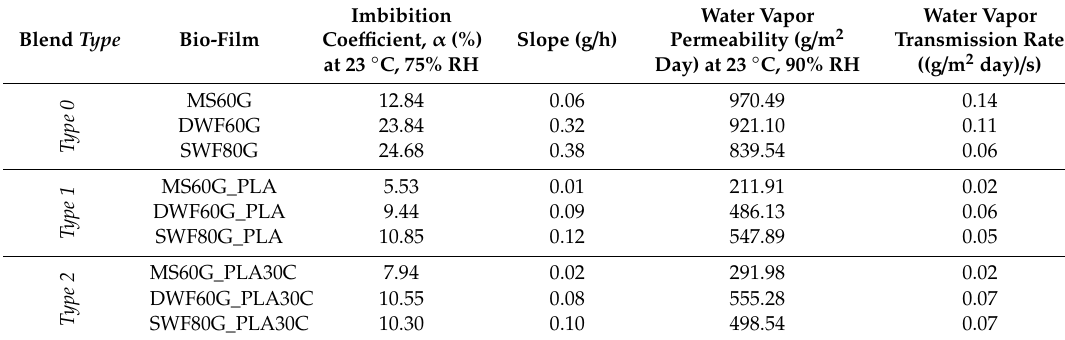
Table 4. Hygroscopic and water vapor permeability data of maize starch (MS)-based, durum